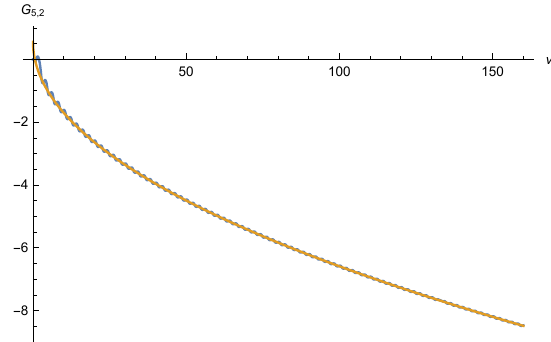
Figure 4 . Subleading tail in G J =0 for GFF as a function of (cid:23) . Parameters are chosen to be d = 3, 5 ; 2 J = 0, (cid:14) (cid:30) = 5 . We subtracted from both sides of (6.3) the leading (cid:23) 5 = 2 term. This way matching 8 of the subleading tail can be seen very clearly. We (cid:12)t b 3 (cid:25) 0 : 565. We see that asymptotic formula works very well even for small (cid:23) .